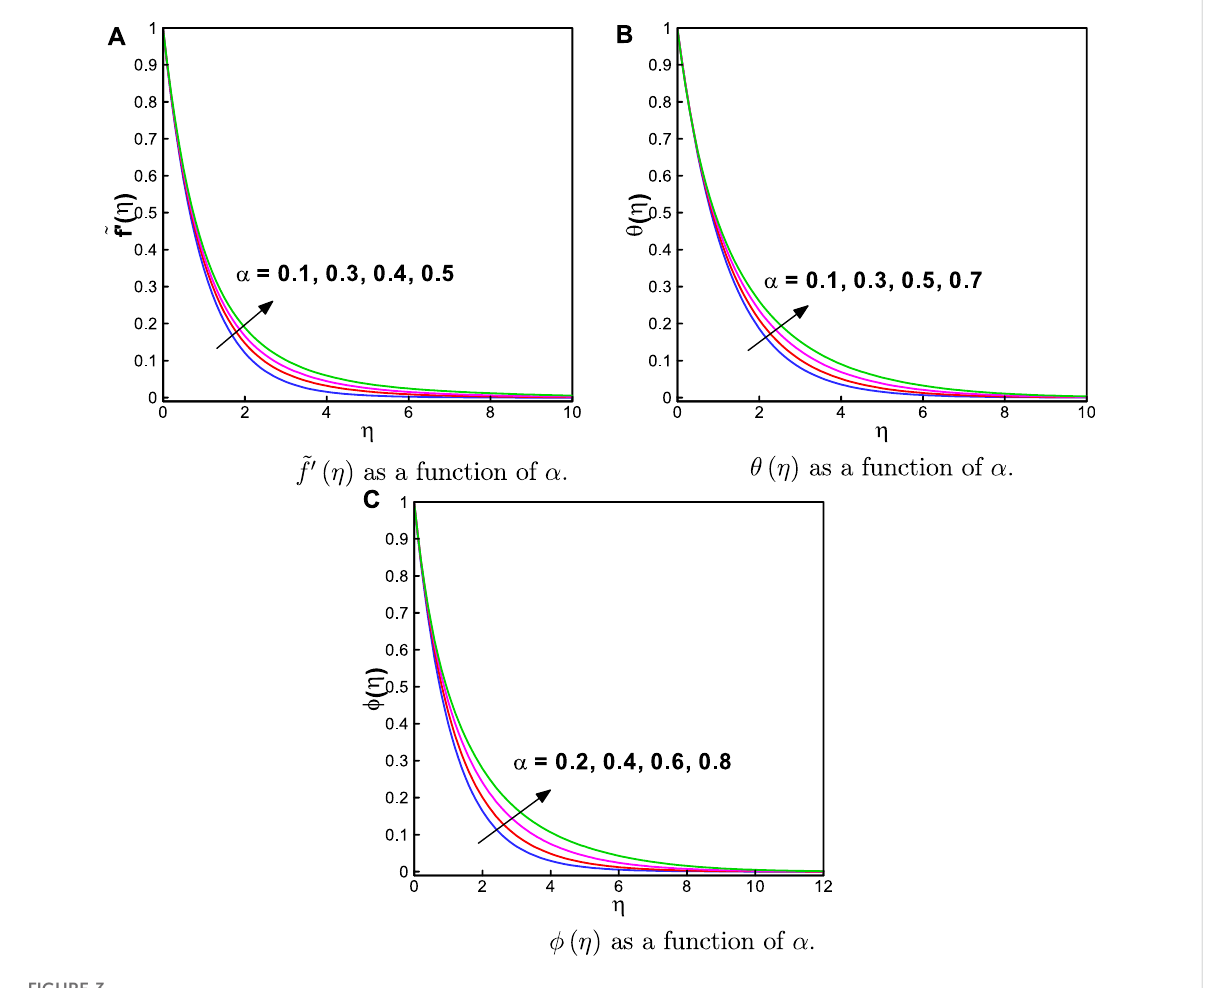
FIGURE 3 (A) ~ f ′ ( η ) as a function of α . (B) θ ( η ) as a function of α . (C) ϕ ( η ) as a function of α